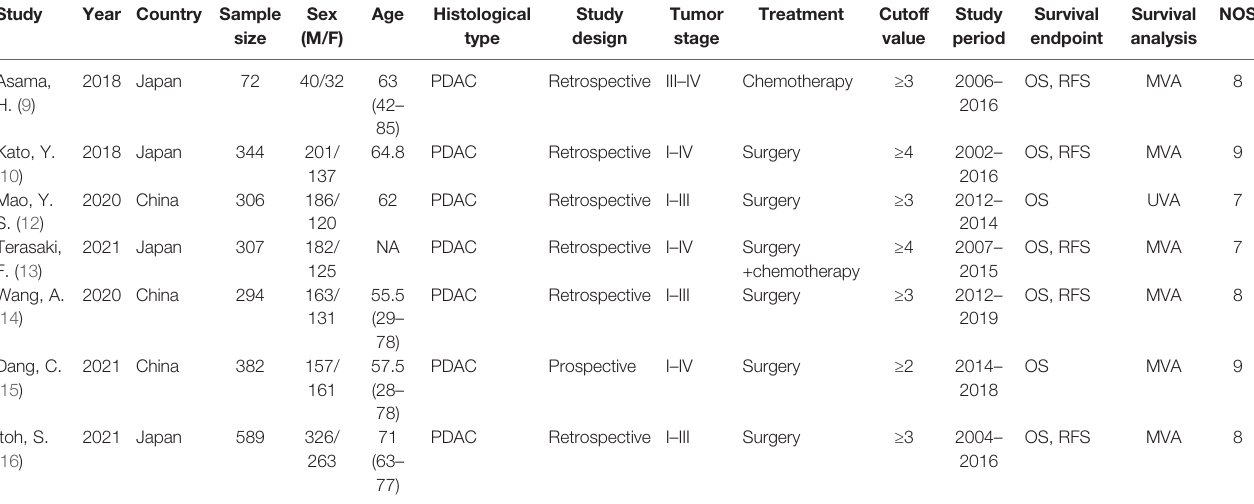
TABLE 2 | Baseline characteristics of included in this